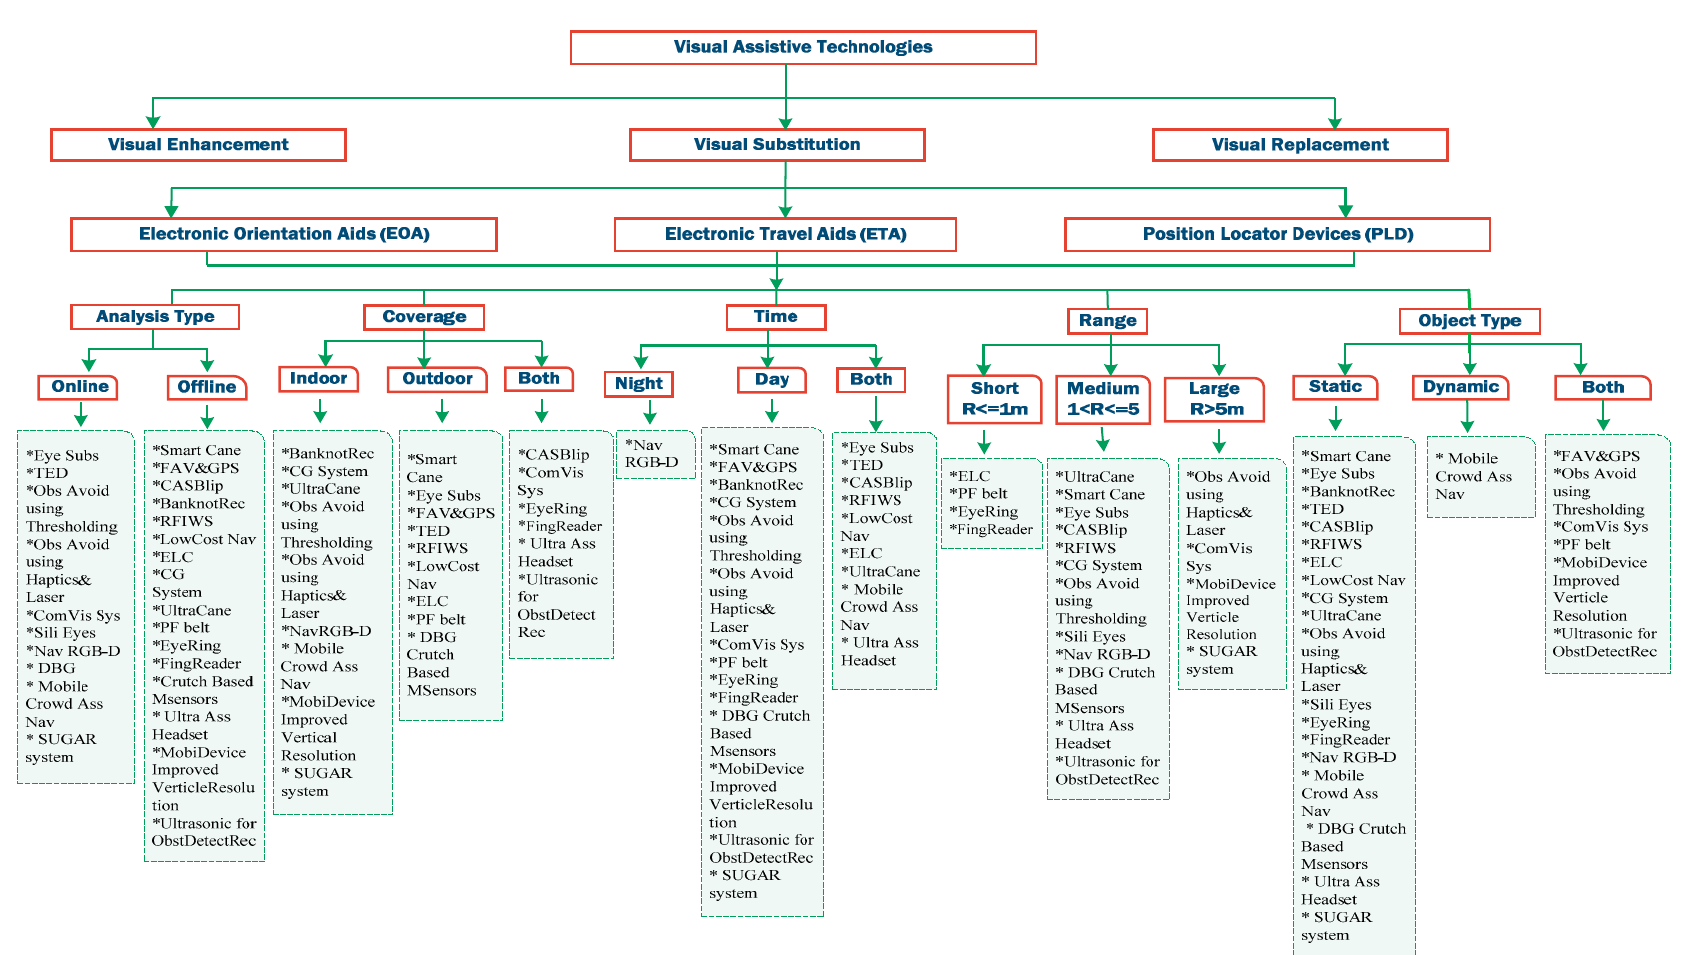
Figure 1. Classification of electronic devices for visually-impaired people.